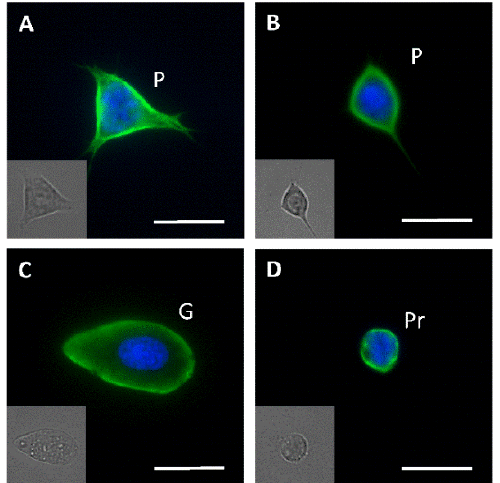
Figure 6. ( A – D ) Immunofluorescence microscopy of fifth instar nymphs hemocytes of Dipetalogaster maxima employing an anti-tubulin primary antibody. The insets show the corresponding differential interference contrast (DIC) images. The nuclei were stained with DAPI. P, plasmatocyte; G, granulocyte; Pr, prohemocyte. Bars: 10 μ m.